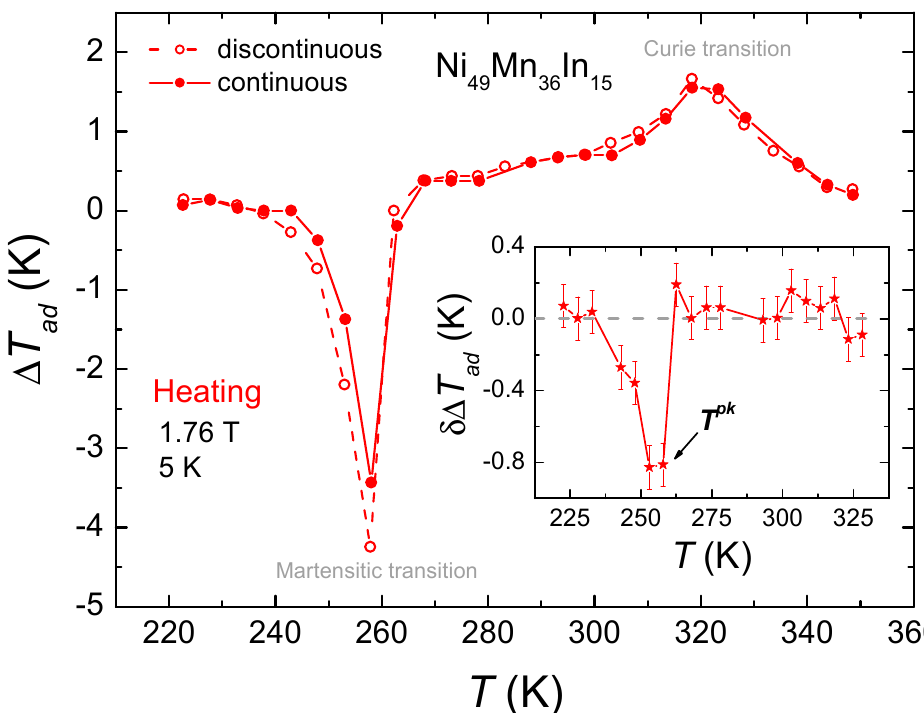
Figure 3. Temperature dependence of the adiabatic temperature change ( Δ T ad ) of Ni 49 Mn 36 In 15 sample using discontinuous and continuous heating protocols (open and solid symbols, respectively) with a temperature step of 5 K. Inset: differences between both Δ T ad curves ( δΔ T ad ).